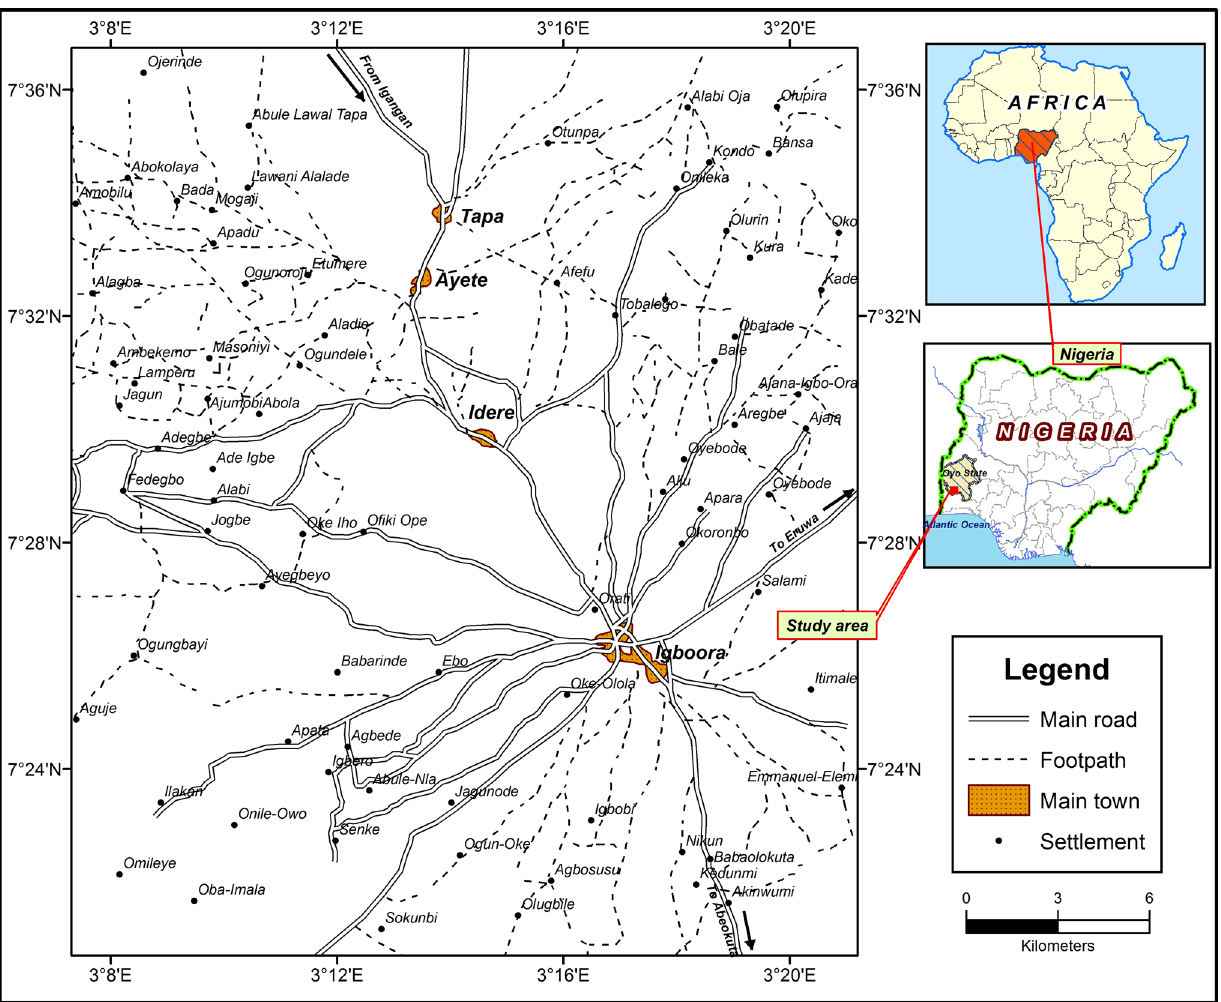
Fig. 1 Location and accessibility map of the study